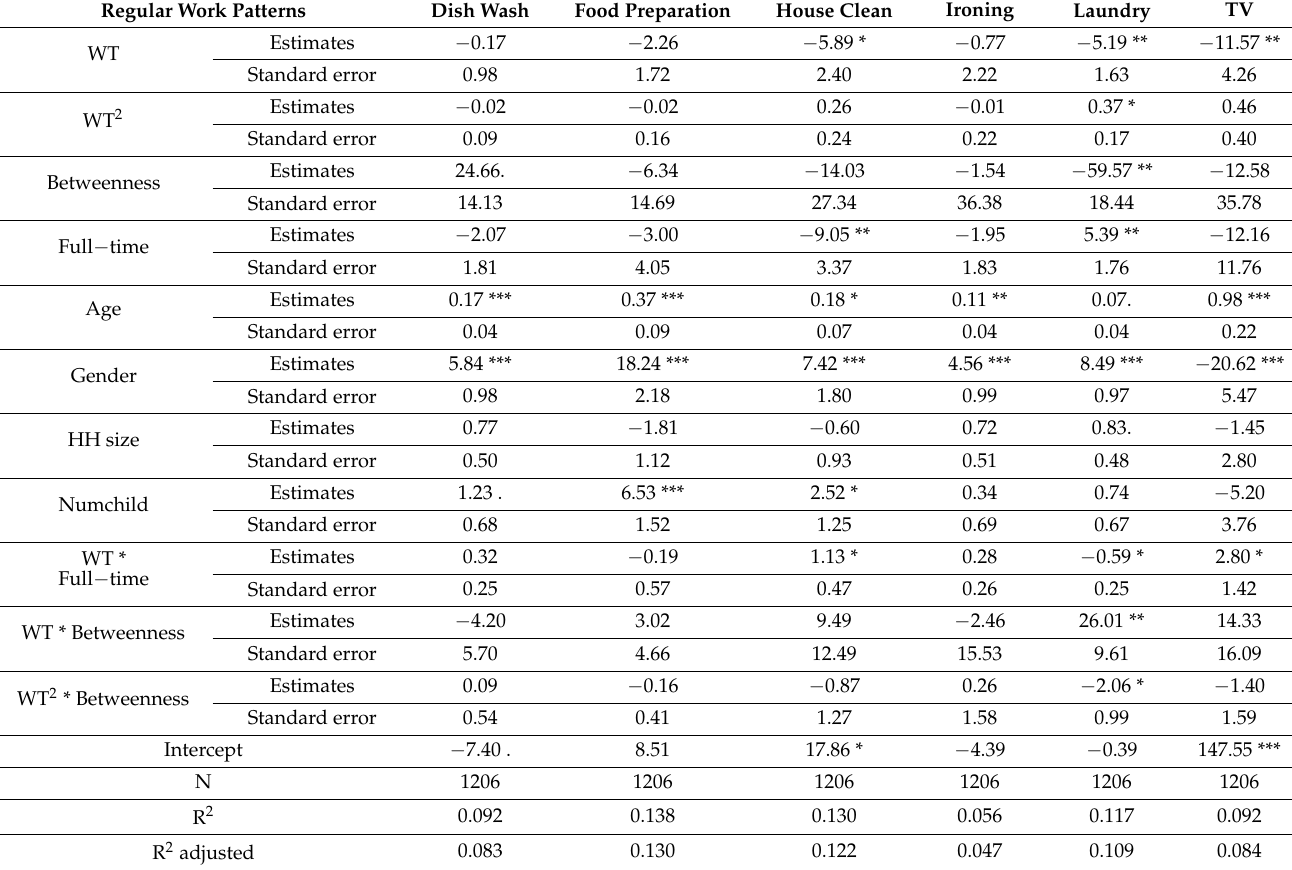
Table 4. The marginal effect of regular work patterns on time usage.